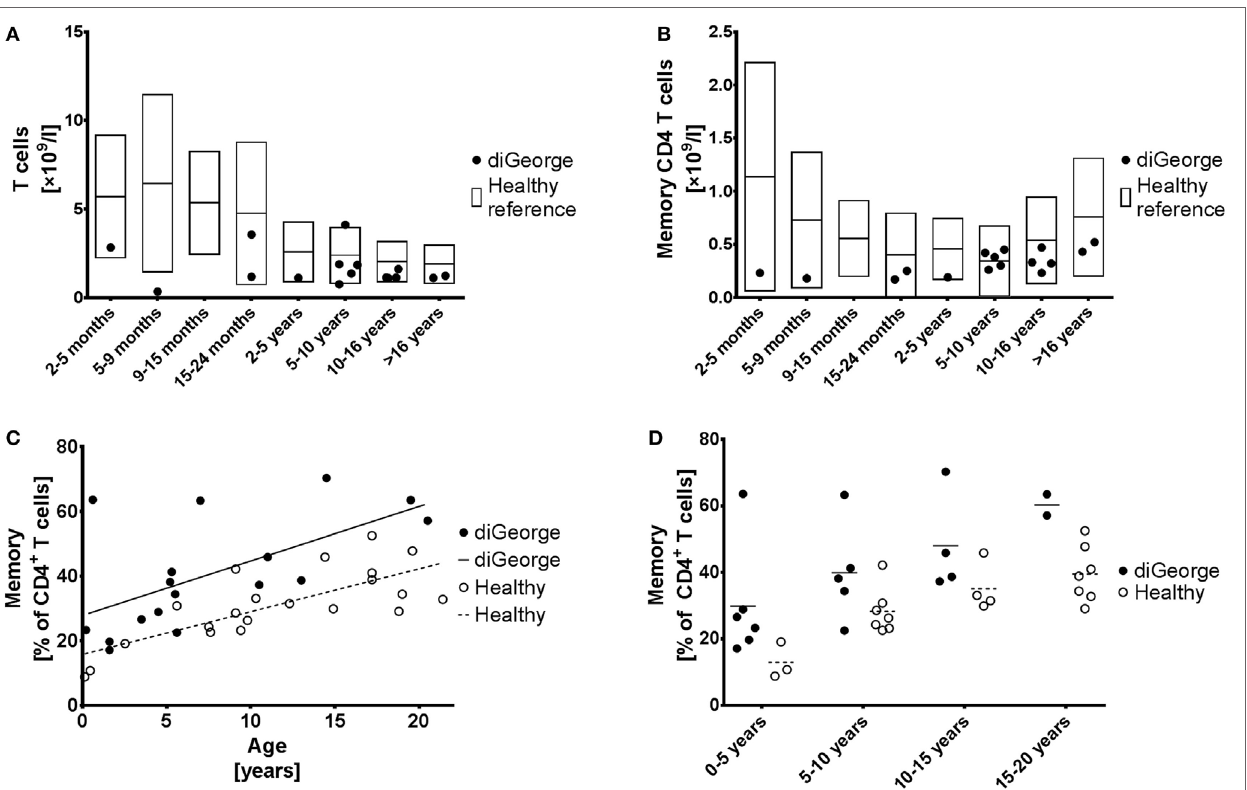
Table describing patients with DiGeorge syndrome included in this study, including basic laboratory and clinical data.